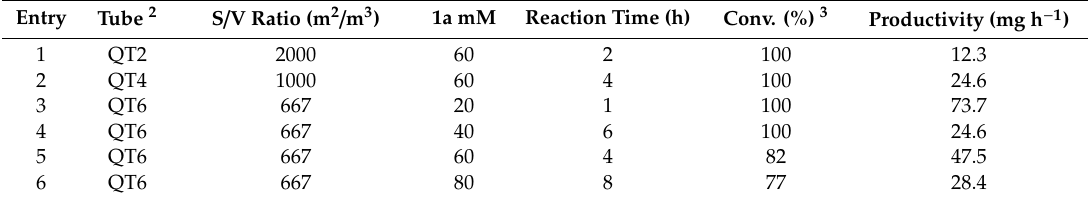
Table 1. Selected results of photoreaction of 1a to 2a under batch 1 .